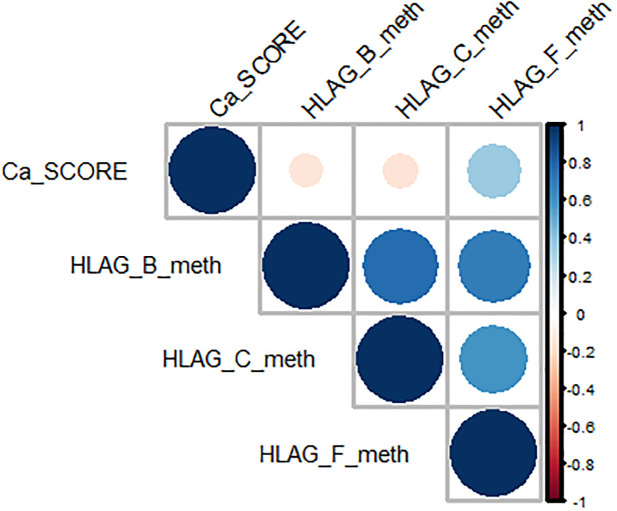
5’CpGHLA-G methylation and Ca score correlation.Correlation plot for Ca score continuous variables and HLA-G nucleotides methylation levels (B, C, F).